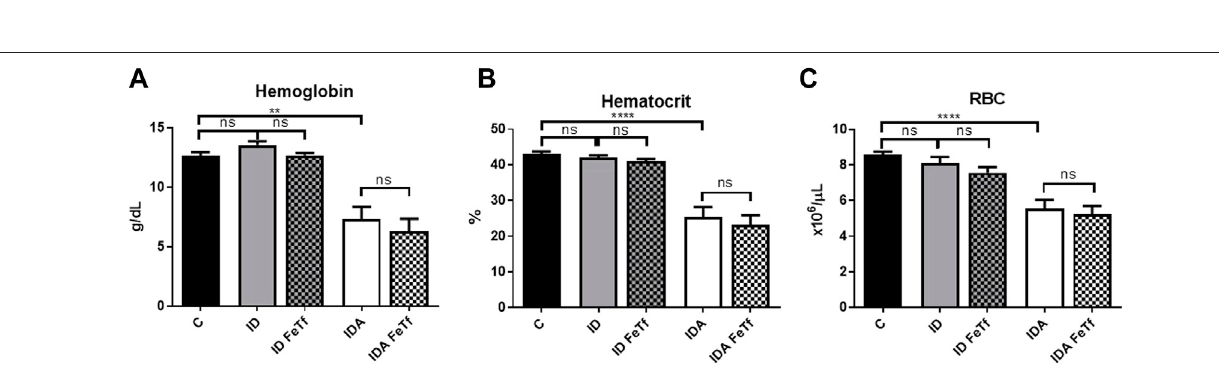
Frontiers in Physiology |